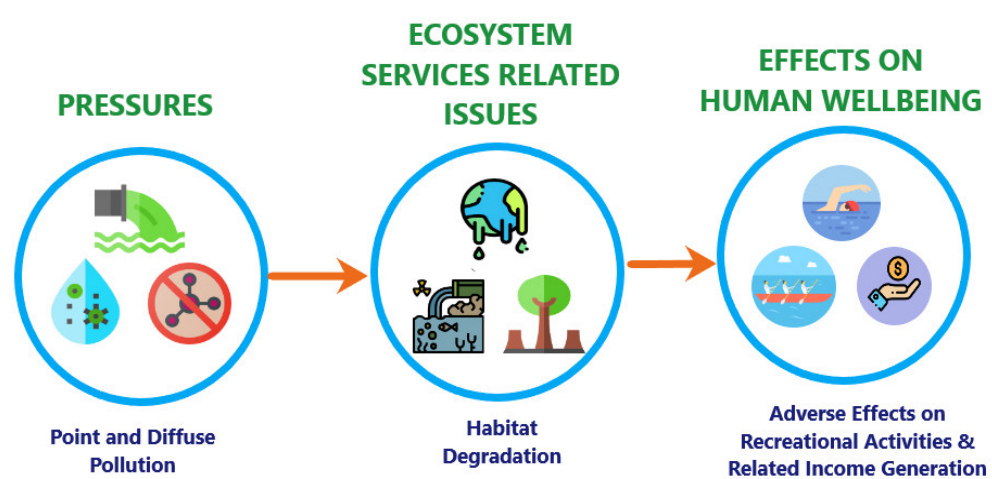
Figure 3. Linking Pressures and Human Wellbeing via Ecosystem Services (Icons by Freepik from www.flaticon.com).